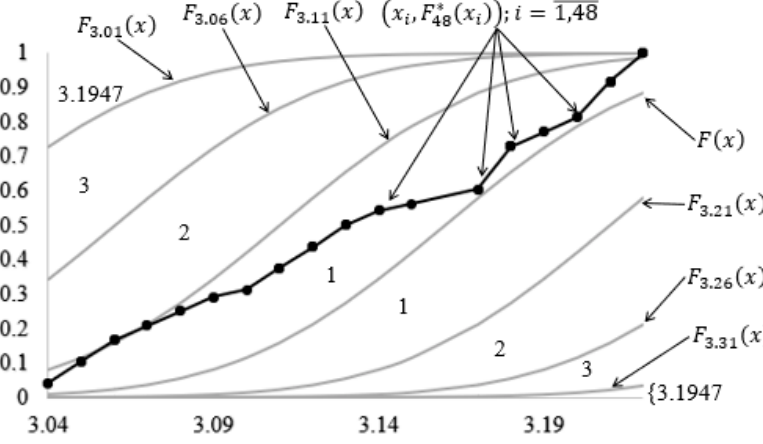
Figure 9. Zones and points (cid:3435)𝑥 (cid:3036) ,𝐹 (cid:2872)(cid:2876)∗ (𝑥 (cid:3036) )(cid:3439); 𝑖 = 1,48(cid:3364)(cid:3364)(cid:3364)(cid:3364)(cid:3364)(cid:3364) for obtained data—Known parameters.